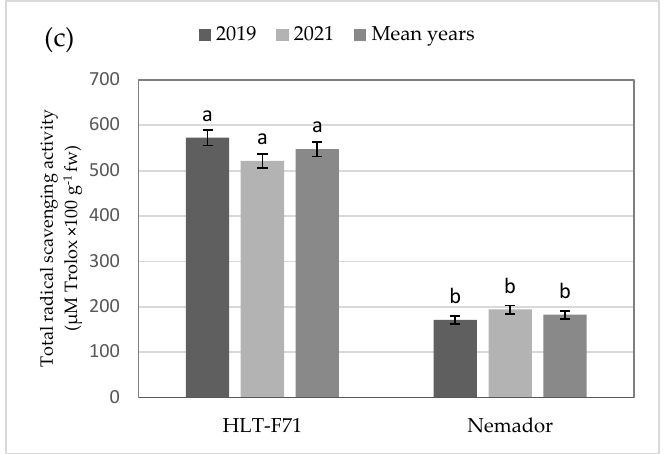
Figure 1. ( a ) Lipophilic, ( b ) hydrophilic and ( c ) total radical scavenging activity of the tomato varieties grown organically during the two growing seasons. Error bars represent ±S.E. ( n = 4). a,b Within each year, means with different letters are significantly different at p < 0 . 05 by LSD test.